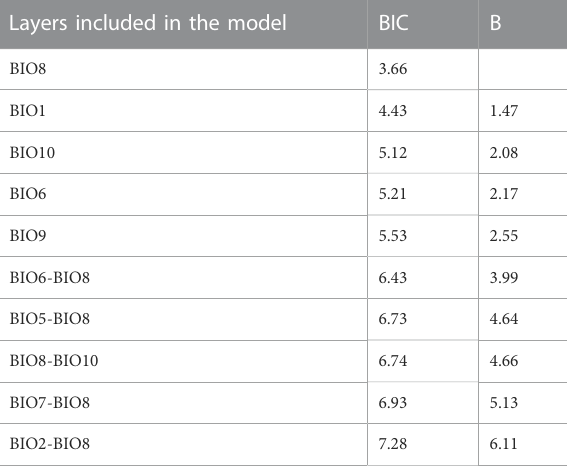
TABLE 2 Bayesian Information Criterion (BIC) values and Bayes factors (B) estimated bytheheuristic procedureimplementedforMinimumAdequate Model (MAM) selection for Procambarus clarkii . Only the 10 models showingthelowestBICvaluesarereported.SeeTable1forlayeracronyms. Layers included in the model